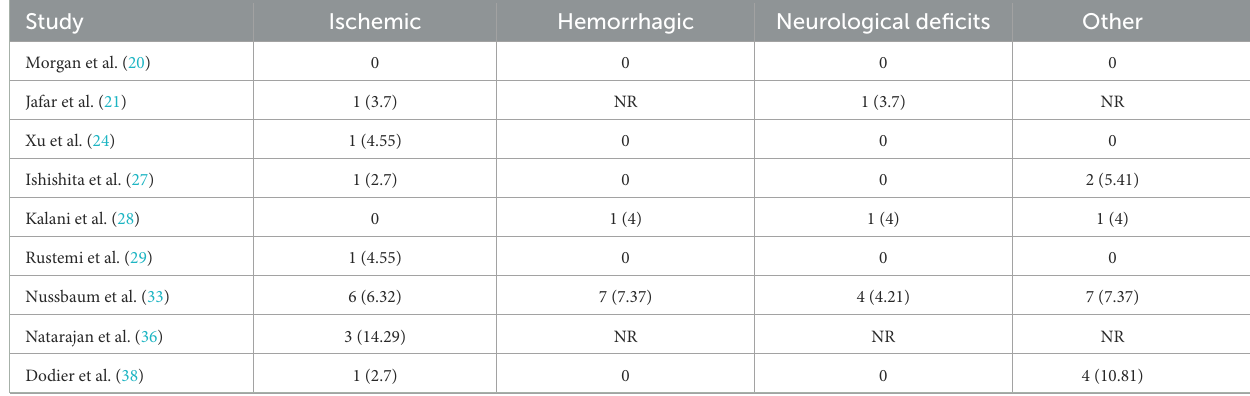
TABLE 5 Secondary outcomes of included